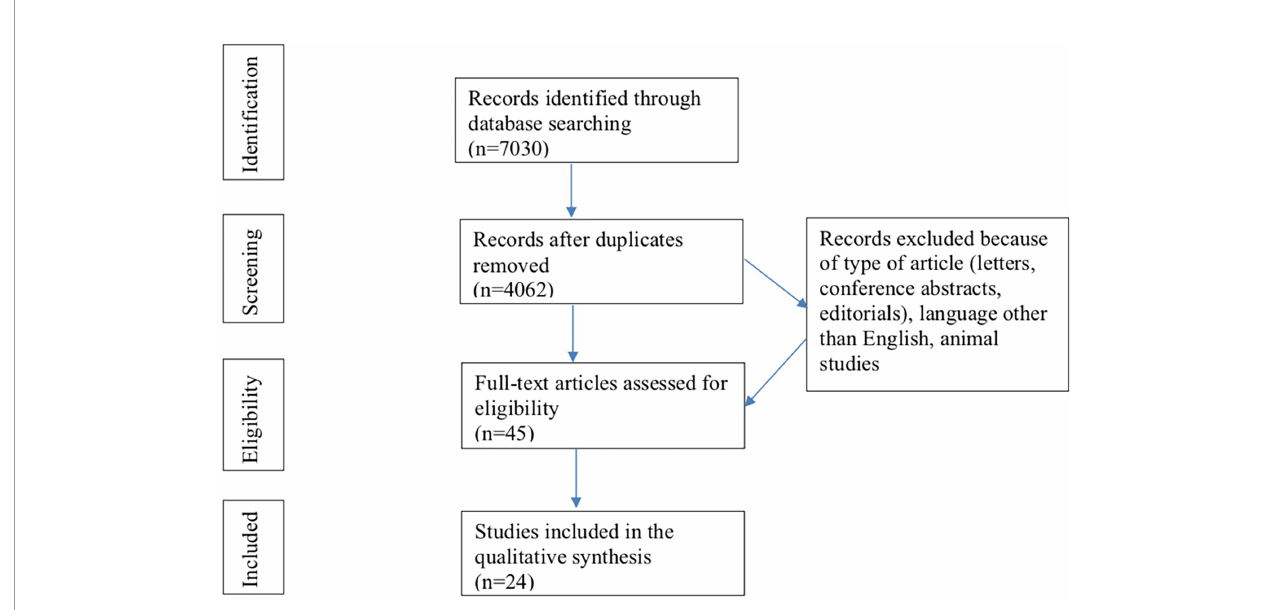
FIGURE 2 | Flowchart of in- and excluded